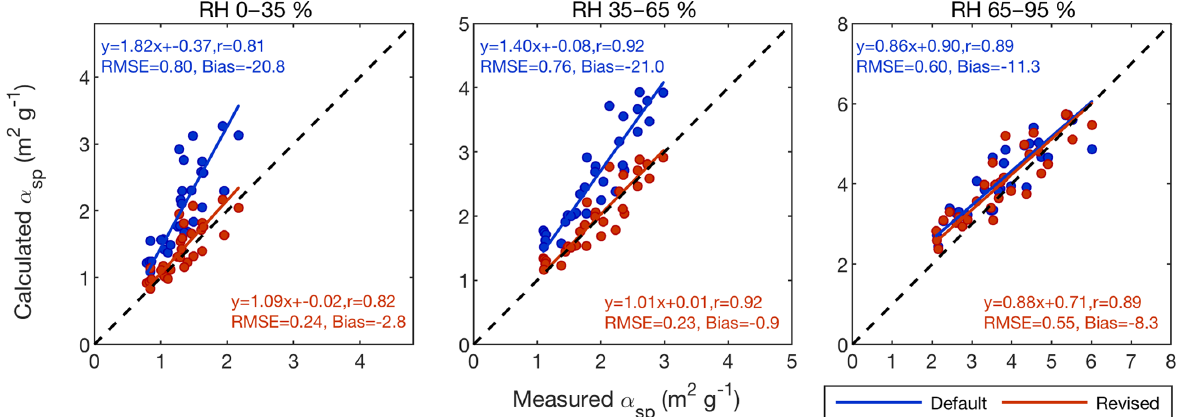
Figure 3. Average measured vs. calculated α sp at 550nm at IMPROVE sites between 2000 and 2010 using GEOS-Chem default and revised optical tables (Table A1) for measurements taken in 0%–35%, 35%–65%, and 65%–95% RH conditions. The 1 : 1 line is black. Slope, offset, and correlation coefficient are